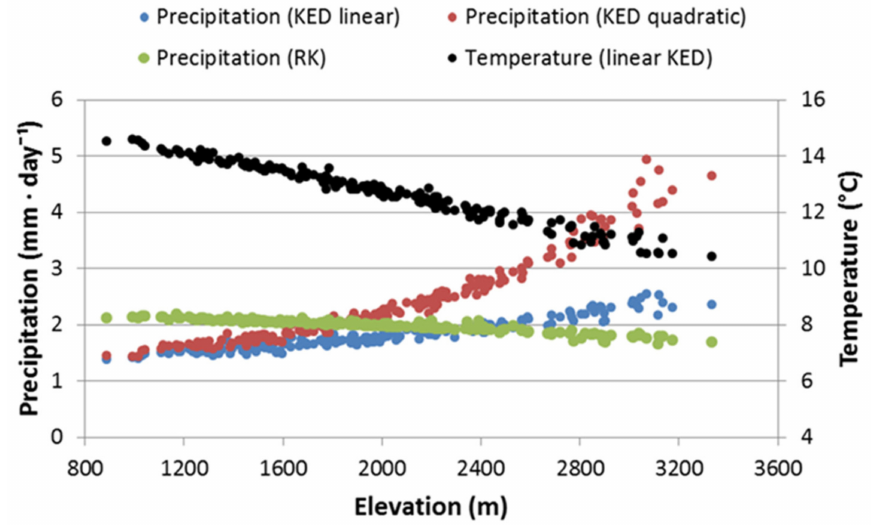
Figure 7. Estimated mean daily temperature and precipitation data depending on elevation in Canales